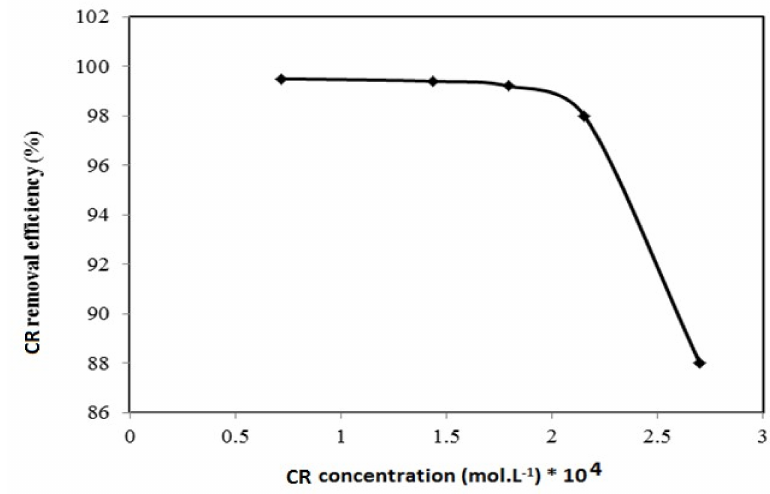
Figure 12. E ff ect of CR concentrations on the removal e ffi ciency of CR for of QVP / AAm-Fe 3 O 4 at optimum contact time and room